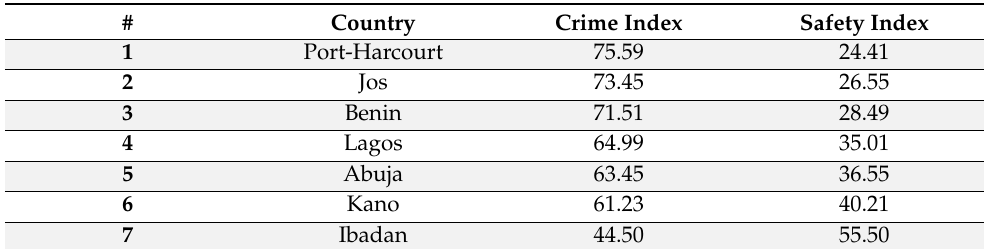
Table 2. Crime rates comparison between major cities in Nigeria. (Data source: [62] and authors’ own